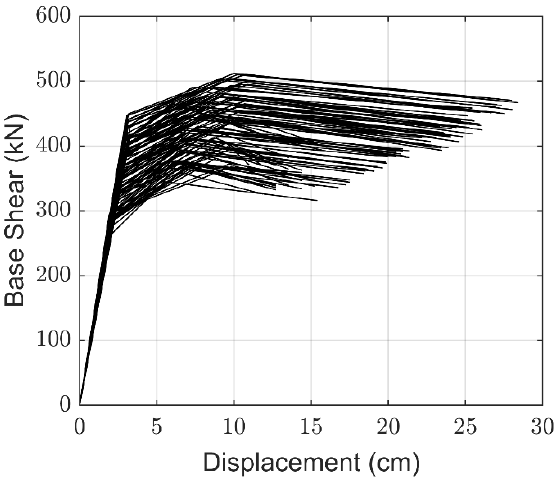
Figure 8. Parametric analytical pushover curves of the considered building typology for varying basic geometrical and mechanical parameters, given in Table 3. Table 4. Fragility curve parameters (mean µ and coefficient of variation V of the PGA-based capacity) for three Damage/Limit States.